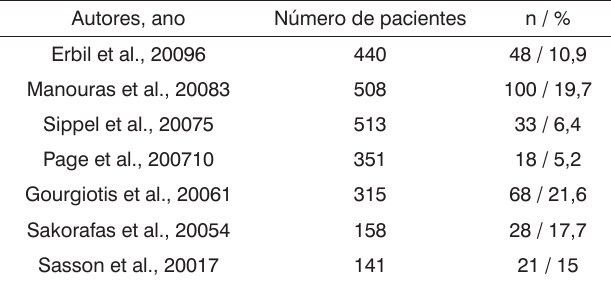
1. Gourgiotis S, Moustafellos P, Dimopoulos N, Papaxoinis G, Baratsis S, Hadjiyannakis E. Inadvertent parathyroidectomy during thyroid surgery: the incidence of a complication of thyroidectomy. Langen- becks Arch Surg. 2006;391(6):557-60. 2. Ondik MP, McGinn J, Ruggiero F, Goldenberg D. Unintentional parathyroidectomy and hypoparathyroidism in secondary central compartment surgery for thyroid cancer. Head Neck. 2010;32(4):462-6. 3. Manouras A, Markogiannakis H, Lagoudianakis E, Antonakis P, Genetzakis M, Papadima A, et al. Unintentional parathyroidectomy during total thyroidectomy. Head Neck. 2008;30(4):497-502. 4. Sakorafas GH, Stafyla V, Bramis C, Kotsifopoulos N, Kolettis T, Kassaras G. Incidental parathyroidectomy during thyroid surgery: an underappreciated complication of thyroidectomy. World J Surg. 2005;29(12):1539-43. 5. ippel RS, Ozgül O, Hartig GK, Mack EA, Chen H. Risks and conse- quences of incidental parathyroidectomy during thyroid